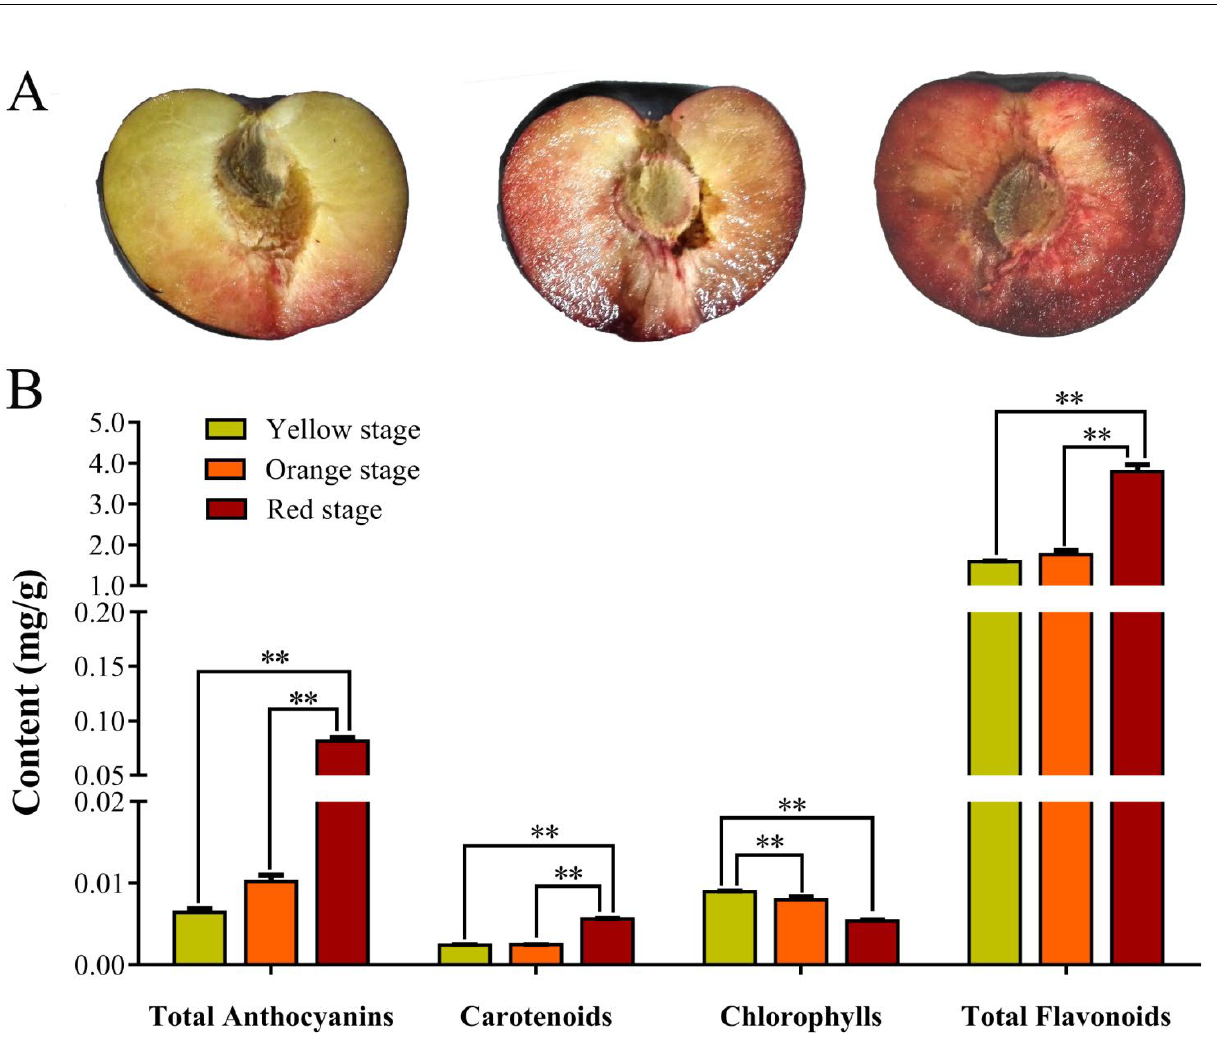
Figure 1. The phenotype of ‘Huaxiu’ plums fruits and pigment contents in the pulp. ( A ): Images of ‘Huaxiu’ plums fruits pulp at different coloration stages. ( B ): Contents of total anthocyanin, chlorophylls, carotenoids, and total flavonoids in the pulp of three coloration stages. The vertical bars represent the standard error of triplicate experiments. ** indicates significant differences in comparison to stems at p < 0.01. Table 1. Summary of sequencing and de novo assembly results of